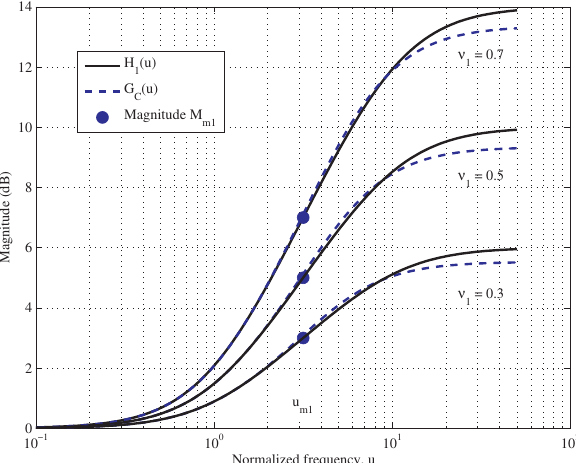
Figure 1. Bode magnitude diagrams of the FLECs H 1 ( ju ) (solid lines) and of the second-order realizations G CH 1 ( ju ) (dashed lines) for ν 1 =